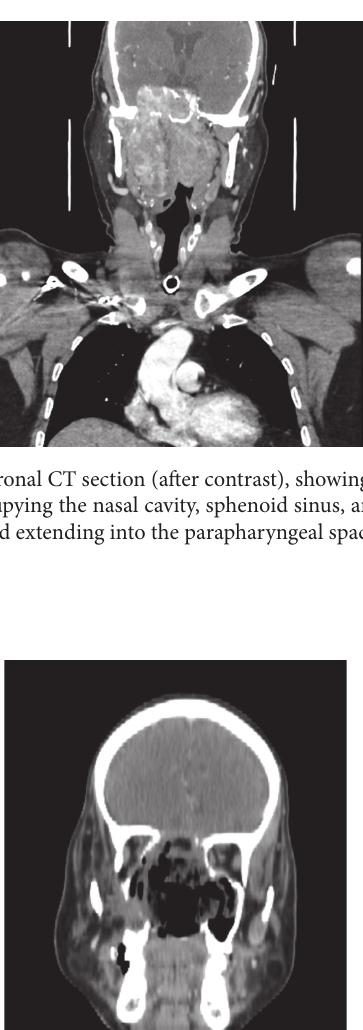
Figure 8: Axial cut of contrast enhanced CT scan of paranasal sinuses showing involvement of parapharyngeal space by Juvenile Nasopharyngeal Angiofibroma.